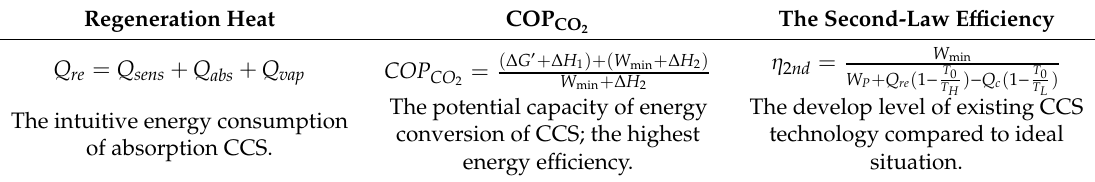
Table 3. Thermodynamic evaluation parameters for CCS.